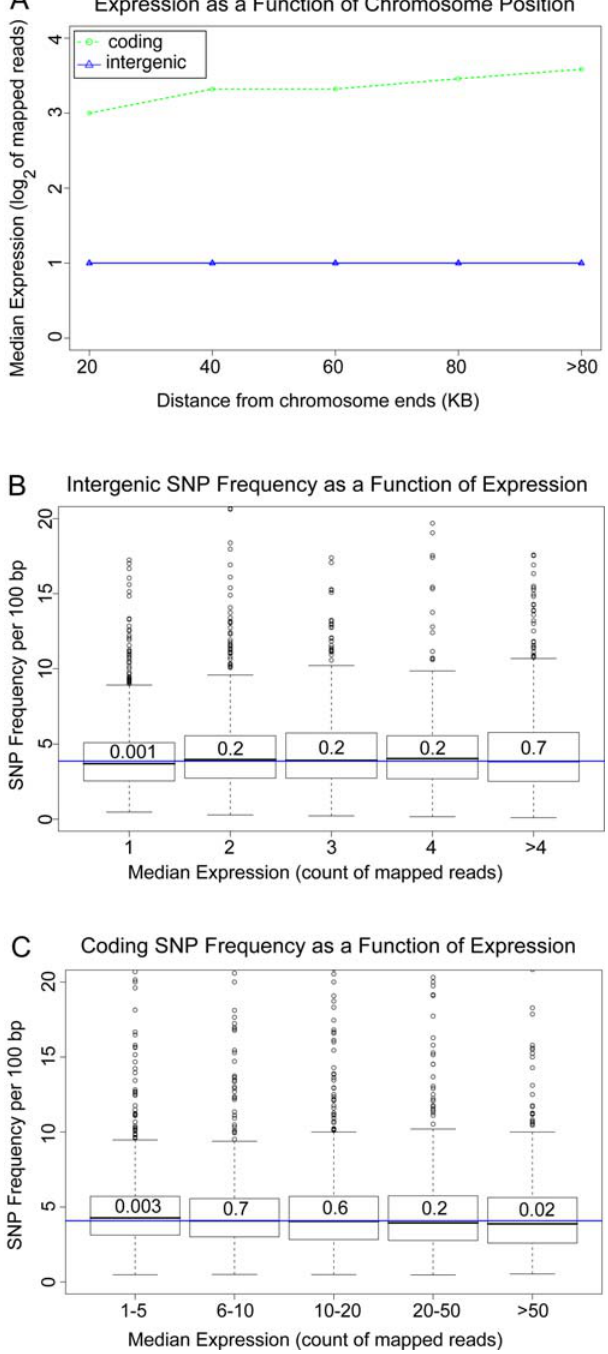
Figure 7. Lack of correlation between expression level and SNP frequency in S. cerevisiae . (A) Median expression for intergenic regions and transcripts, as a function of distance from telomeres. (B) Boxplots of SNP frequencies for intergenic regions, as a function of median expression level. (C) Boxplots of SNP frequencies in fourfold- degenerate synonymous positions of genes, as a function of median expression level. Wilcoxon–Mann–Whitney p-values for each expression level, comparing SNP frequencies against the genome-wide distribu- tion, are indicated within each boxplot.